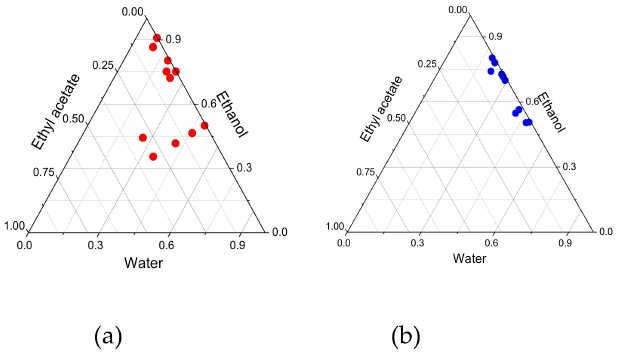
Figure 2. Ternary diagrams showing the proportions in which 80 mg / mL ciclopirox olamine ( a ) and base ( b ) are